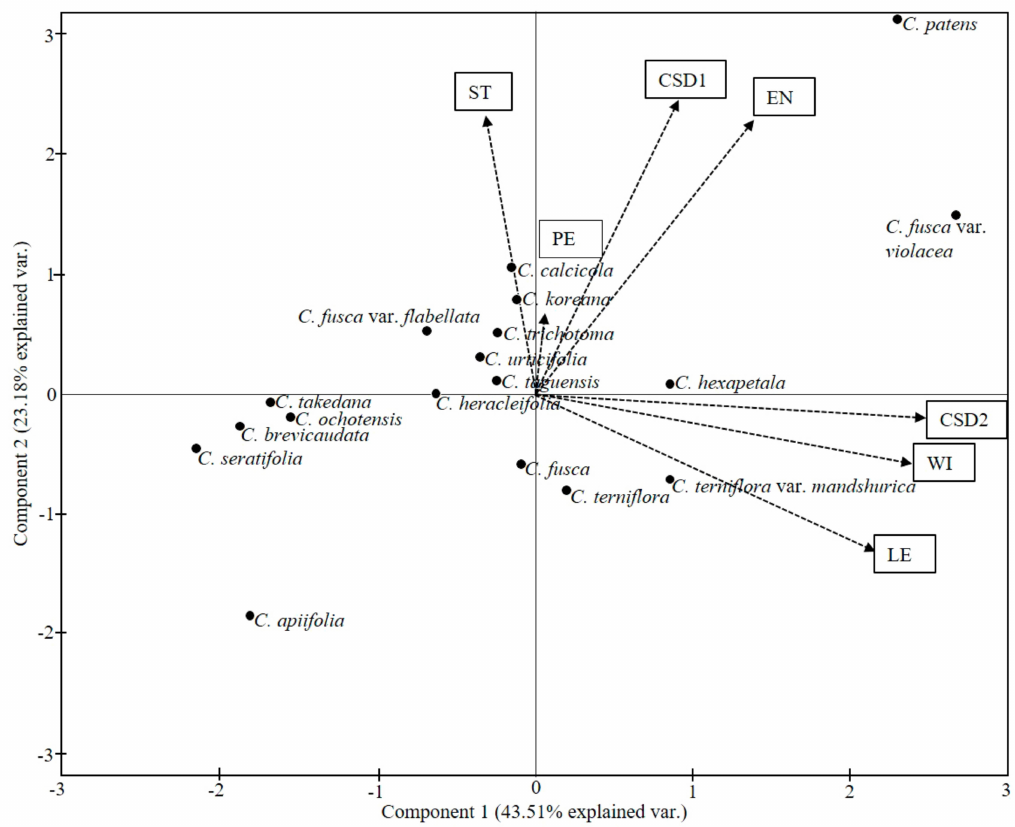
Figure 9. Principal component analysis (PCA) of seven quantitative achene characters of Clematis taxa. CSD1, cross section dimeter parallel to cotyledon; CSD2, cross section dimeter perpendicular to cotyledon; EN, thickness of endocarp; LE, length of achene; PE, thickness of pericarp; ST, length of style; WI,